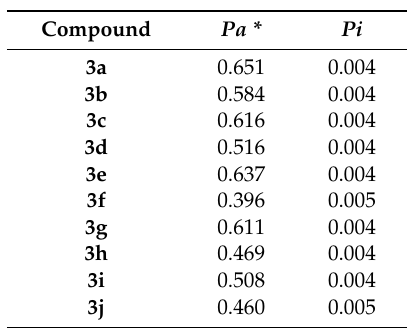
Table 3. Results of PASS program for the phosphodiesterase